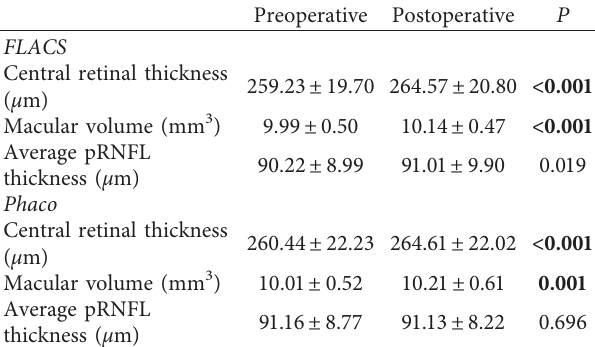
Table 5: Pre- and postoperative values of central macular thick- ness, macular volume, and peripapillary retinal nerve fiber layer (pRNFL) thickness for femtosecond laser-assisted cataract surgery and “classic” phacoemulsification.